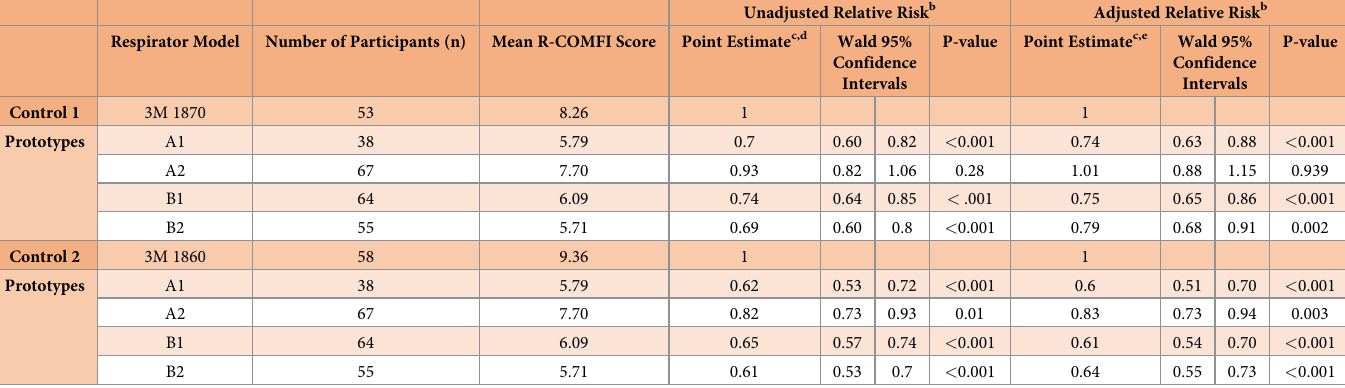
Unadjusted Relative Risk b Adjusted Relative Risk b